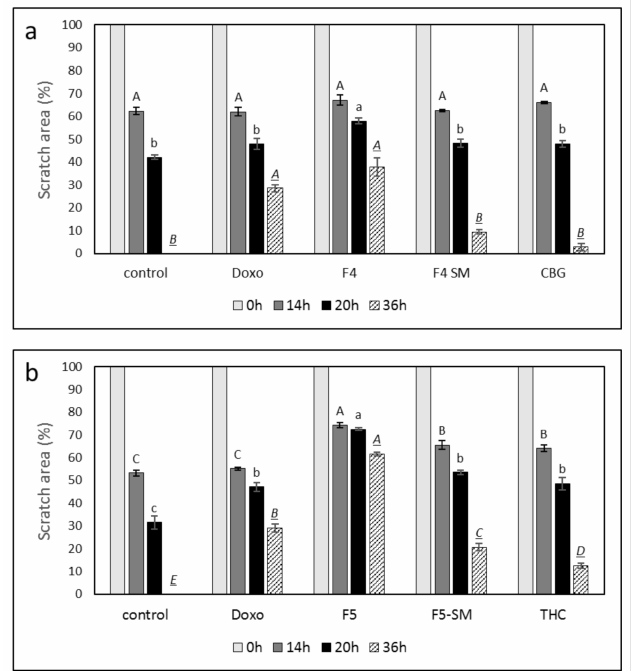
Figure 7. Effect of F4, F5, F4-SM, or F5-SM on A172 cell migration. Cells were treated with ( a ) F4 (20 µ g/mL); F4-SM (11.5 µ g/mL) or CBG (9.2 µ g/mL) ( b ) F5 (20 µ g/mL); F5-SM (11.5 µ g/mL) or THC (10.5 µ g/mL). Control is vehicle control (1.15% v / v methanol). Doxorubicin (Doxo, 0.5 µ g/mL) served as a positive control. Percent scratch area is presented as mean; error bars indicate ± SE ( n = 3). Levels with different letters are significantly different from all combinations of pairs according to the Tukey–Kramer honest significant difference (HSD; p ≤